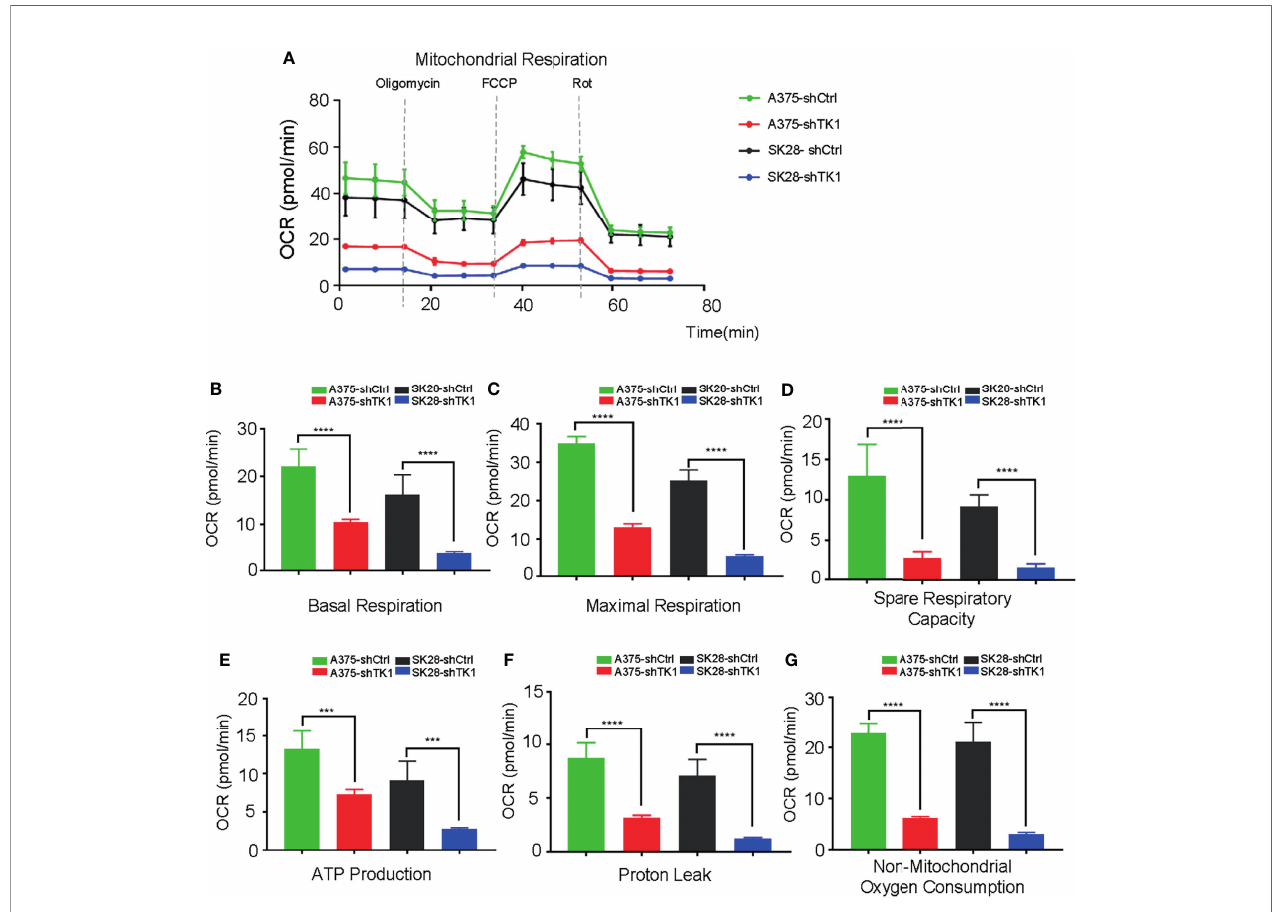
FIGURE 5 | The oxygen consumption rate (OCR) was suppressed in thymidine kinase 1 (TK1) knockdown group. (A) The mitochondrial respiration curve of control group and TK1 downregulation group. (B – G) The basal respiration, maximal respiration, spare respiratory capacity, ATP production, proton leak, and non- mitochondrial oxygen consumption were inhibited in TK1 knockdown group. ***p < 0.001, ****p <